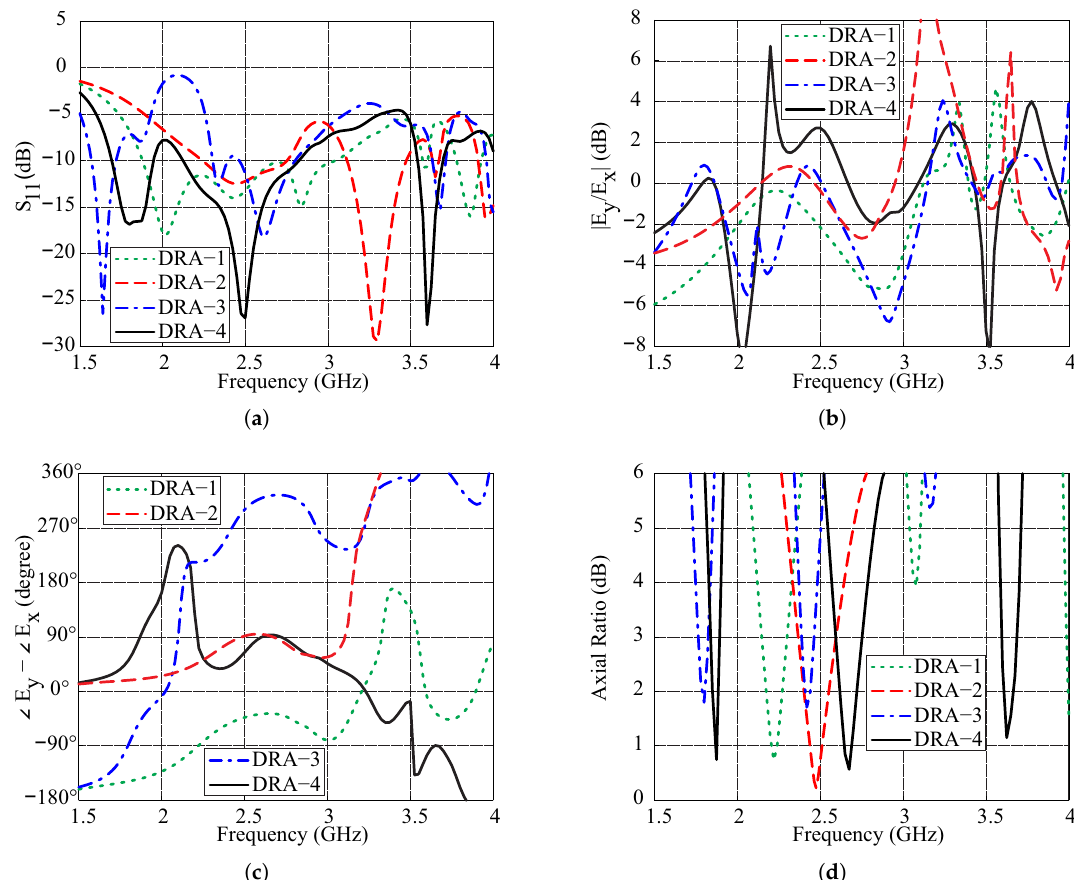
Figure 3. Comparison of the simulated results of DRA-1–DRA-4: ( a ) Reflection coefficients; ( b ) Amplitude ratios; ( c ) Phase differences; ( d ) Axial